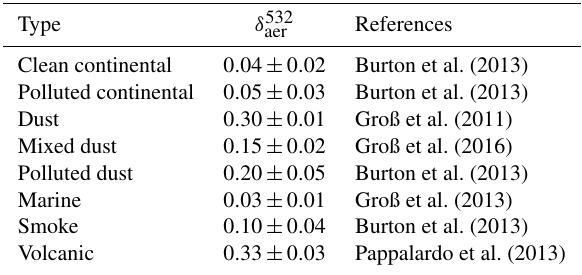
Table 4. The mean and standard deviation of the particle depolar- ization ratio used for the pre-specified classes and the corresponding bibliographic